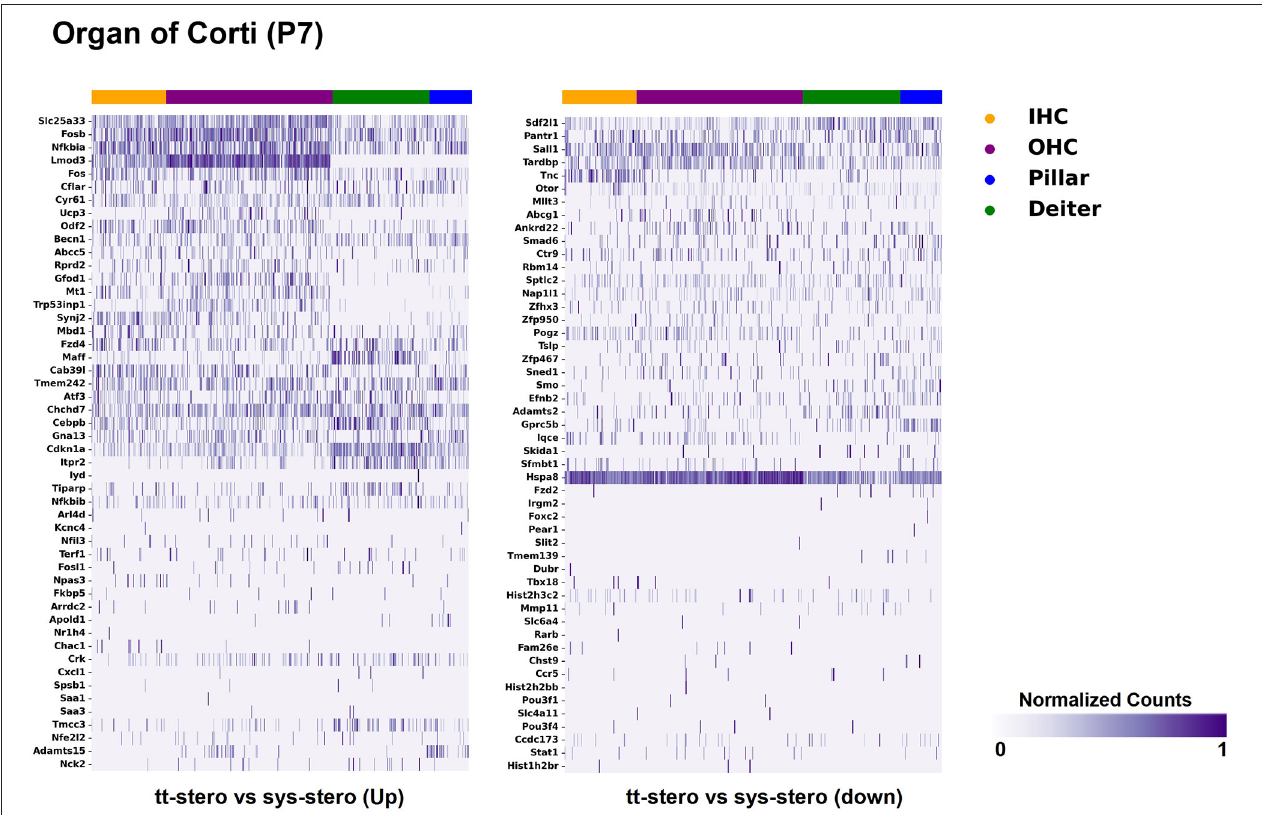
FIGURE 2 | Steroid-responsive gene expression in the adult mouse organ of corti after treatment with transtympanic vs. systemic steroids. Expression of steroid-responsive genes from mice treated with transtympanic vs. systemic steroids in the P7 mouse organ of Corti (OC) single-cell RNA-Seq dataset ( 17). Heatmap (LEFT) localizes genes with increased expression in mice treated with transtympanic vs. systemic steroids to cell types in the P7 mouse OC. Heatmap (RIGHT) localizes genes with decreased expression in mice treated with transtympanic vs. systemic steroids to cell types in the P7 mouse OC. Heatmaps display cells along the horizontal axis with cell types grouped by color with each bar denoting a single cell and genes are displayed along the vertical axis. The darker the bar, the more highly expressed the gene is in a given cell. Expression level is displayed in normalized